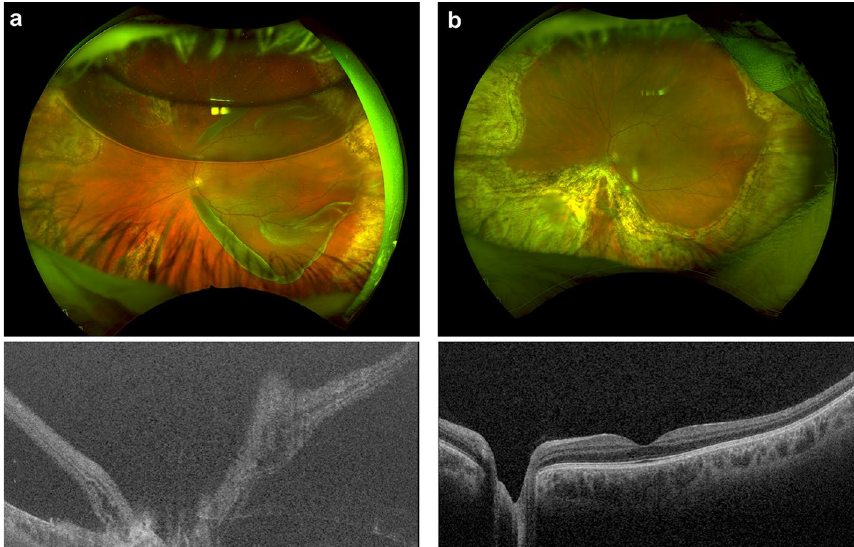
Figure 1. Representative case of a 61-year-old patient with a macula-off rhegmatogenous retinal detachment and giant retinal tear with gas tamponade in situ from a previously failed pars plana vitrectomy ( a ), repaired with DensironXTRA tamponade. Good anatomical outcome at 6 months post-operatively with the DensironXTRA tamponade removed ( b